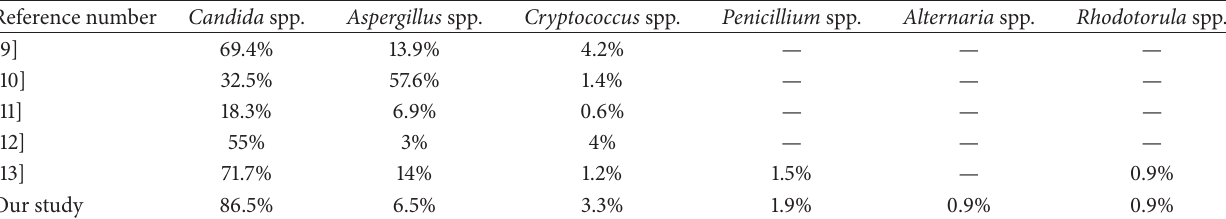
Table 5: Distribution of fungi in HIV positive